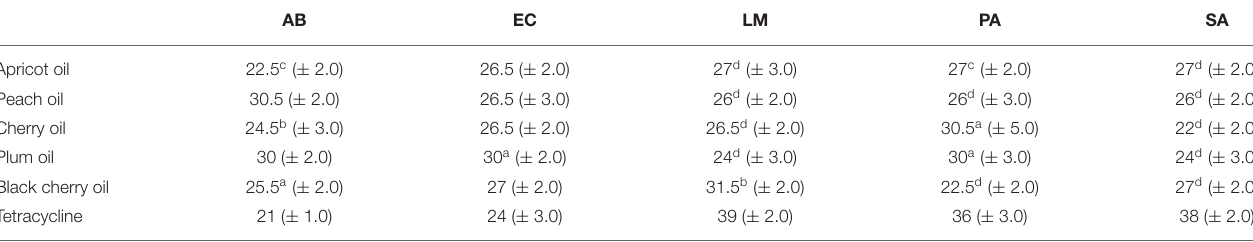
TABLE 5 | Minimal inhibitory concentration (MIC, µ g/ml) of the different cold-pressed seed oils of apricot, cherry, peach, plum, and black cherry needed to block the growth of the five bacterial strains, evaluated by the resazurin test. AB EC LM PA SA Apricot oil Peach oil